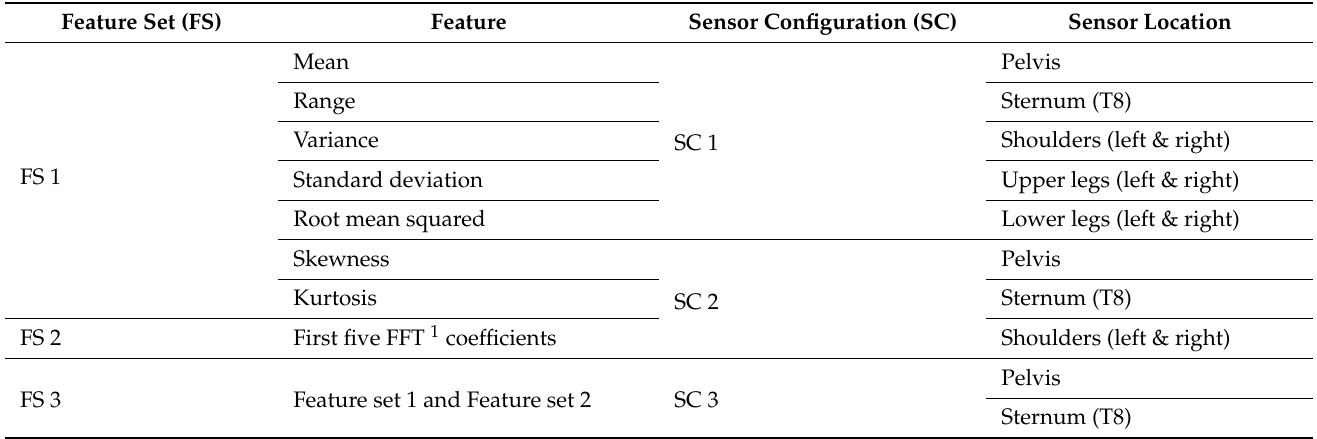
Table 2. Feature sets and sensor combinations for the training of the machine learning